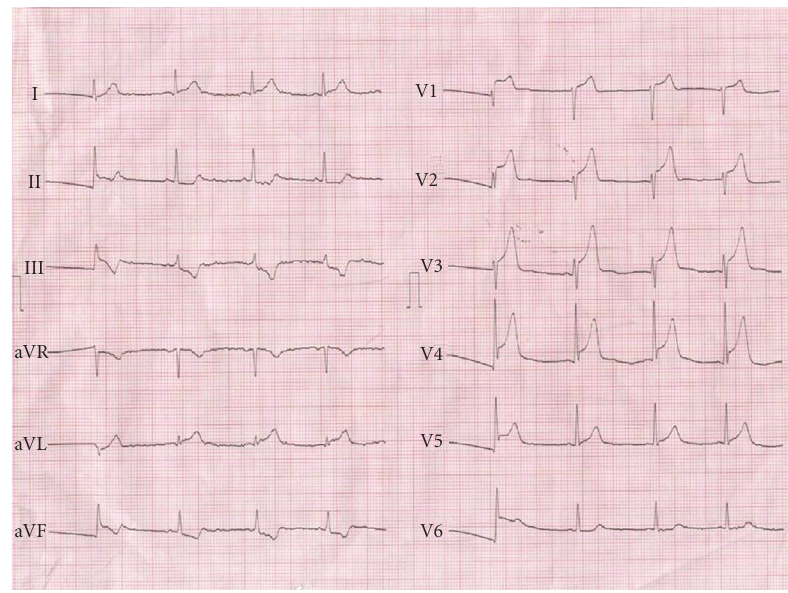
Figure 1: Electrocardiogram presents ST segment elevation in leads of V2–V5 and